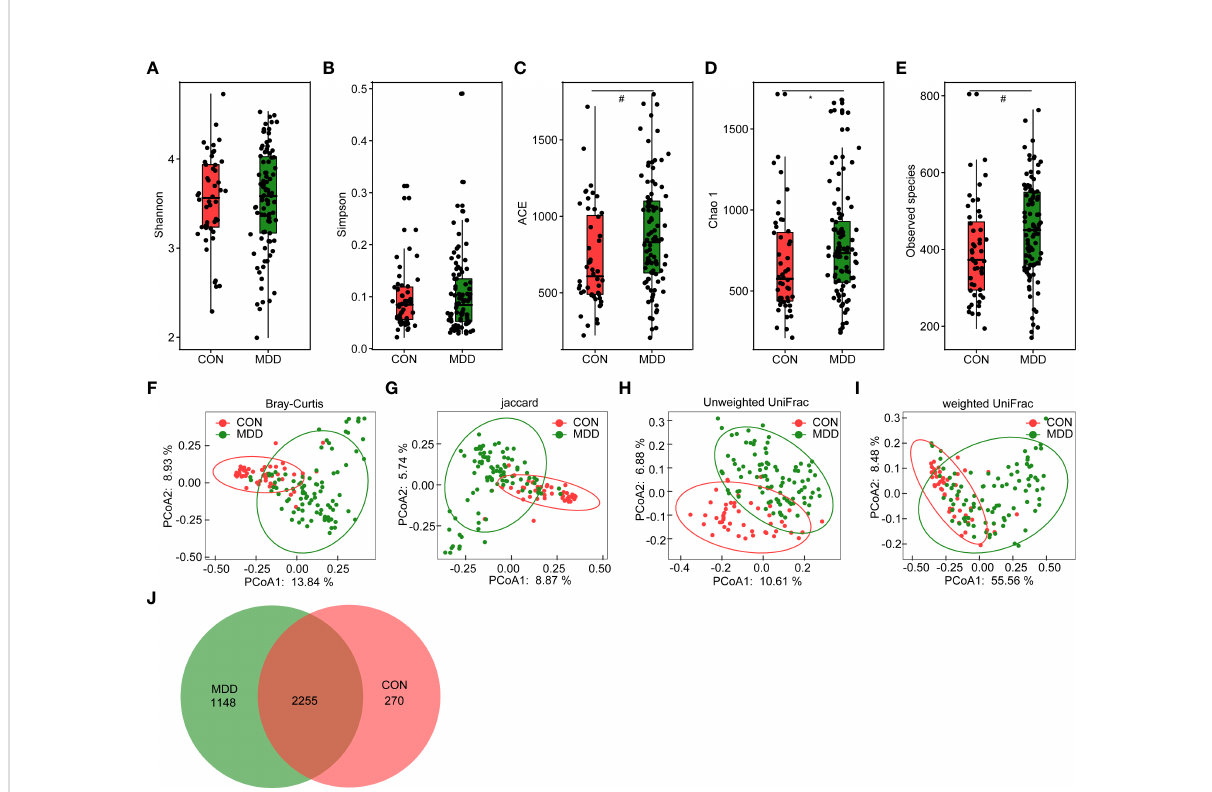
FIGURE 1 Altered overall structure of the fecal microbiota in patients with childhood major depressive disorders (MDD). The diversity indices of Shannon (A) and Simpson (B) , and the richness indices of ACE (C) , Chao1 (D) , and the observed OTUs (E) were used to evaluate the overall structure of the fecal microbiota in childhood MDD patients and the healthy controls. The data are presented as mean ± standard deviation. Unpaired t tests (two tailed) were used to analyze the variation between the groups. *p < 0.05 and # p < 0.01 compared with the control group. Principal coordinate analysis (PCoA) plots of individual fecal microbiota based on Bray – Curtis (F) , jaccard (G) , and unweighted (H) and weighted (I) UniFrac distances in childhood MDD patients and the healthy controls. Each symbol represents a sample. The Venn diagram illustrates the overlap of OTUs in childhood MDD-associated microbiota and healthy controls (J)